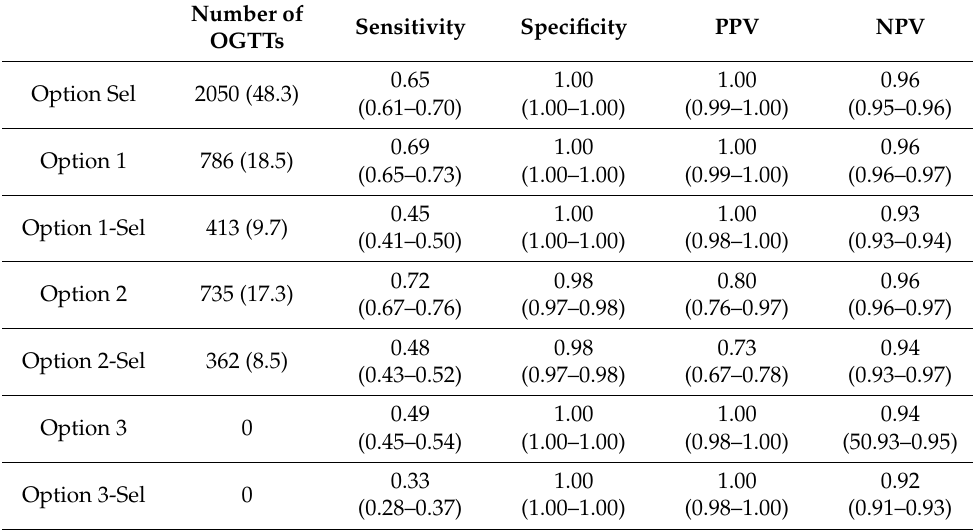
a specific table by option: Option Sel (Supplementary Table S1), Option 1